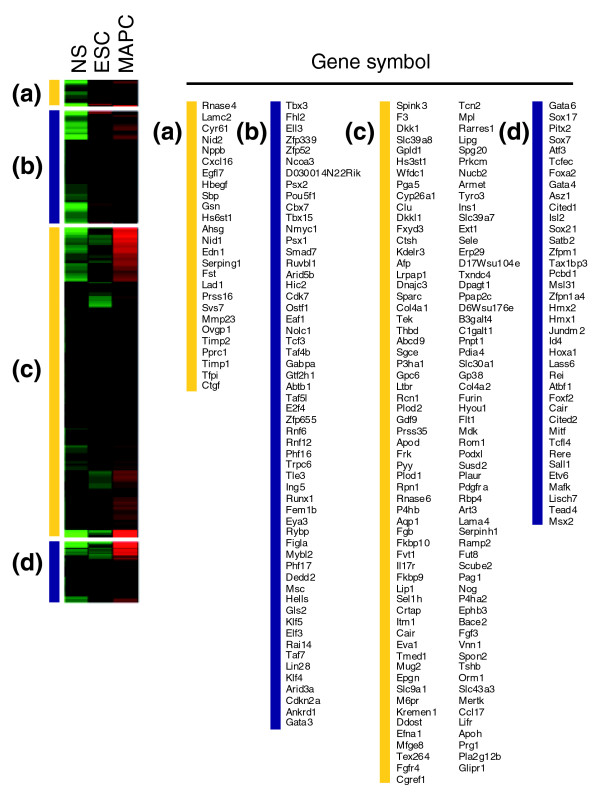
Genes for proteins localized to the extracellular space and for transcriptional regulators clustered according to expression profiles in MAPC/ESC/NS comparison. (a, b) Genes expressed at levels at least twofold higher in both MAPCs and ESCs than in NS (k-means clusters 2 and 4). (c, d) Genes expressed in MAPCs at levels at least twofold higher than in both ESCs and NS (k-means cluster 3). The yellow bars indicate genes whose products are localized to the extracellular space; the blue bars indicate genes for transcriptional regulators. Red and green indicate higher and lower levels of expression, respectively.